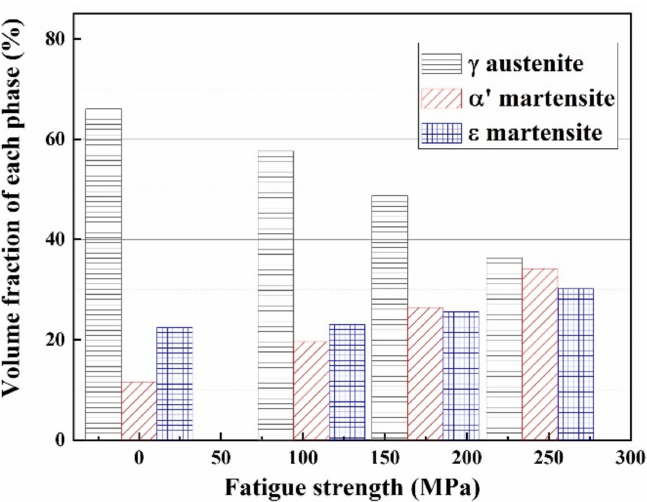
Figure 4. Effect of stress on the volume fraction of each phase in fatigue-damaged Fe-22%Mn-12%Cr- 4%Co-3%Ni-2%Si damping